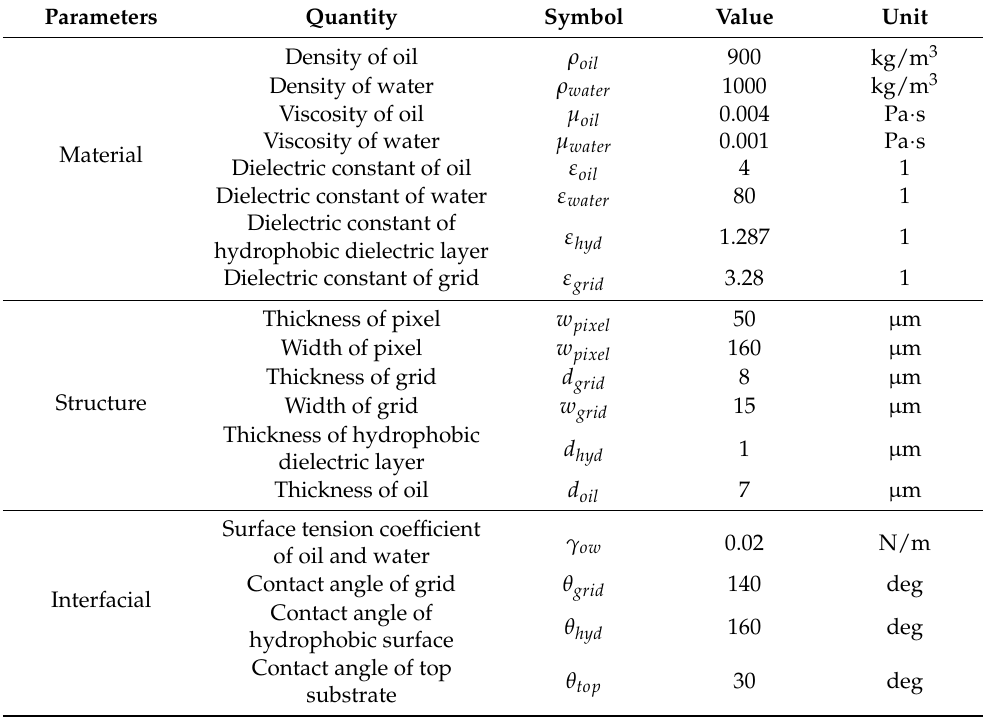
Table 1. Material, structure, and interface parameters used in the